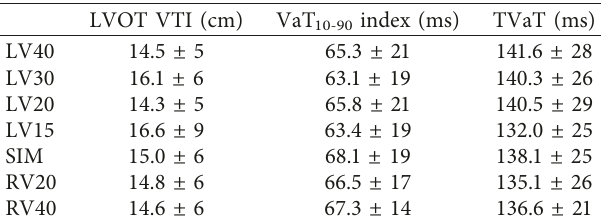
136.6 ± 21 LVOT VTI, left ventricular outflow tract velocity time integral; LVx, in- traventricular pacing interval with the left ventricle paced first by x mil- liseconds; RVx, intraventricular pacing interval with the right ventricle paced first by x milliseconds; SIM, intraventricular pacing interval with the right and left ventricles paced simultaneously; TVaT, total ventricular activation time; VaT 10-90 , ventricular activation time 10-90 . Values were compared by ANOVA and the Kruskal–Wallis test. No between-group comparisons were significant (Tukey’s